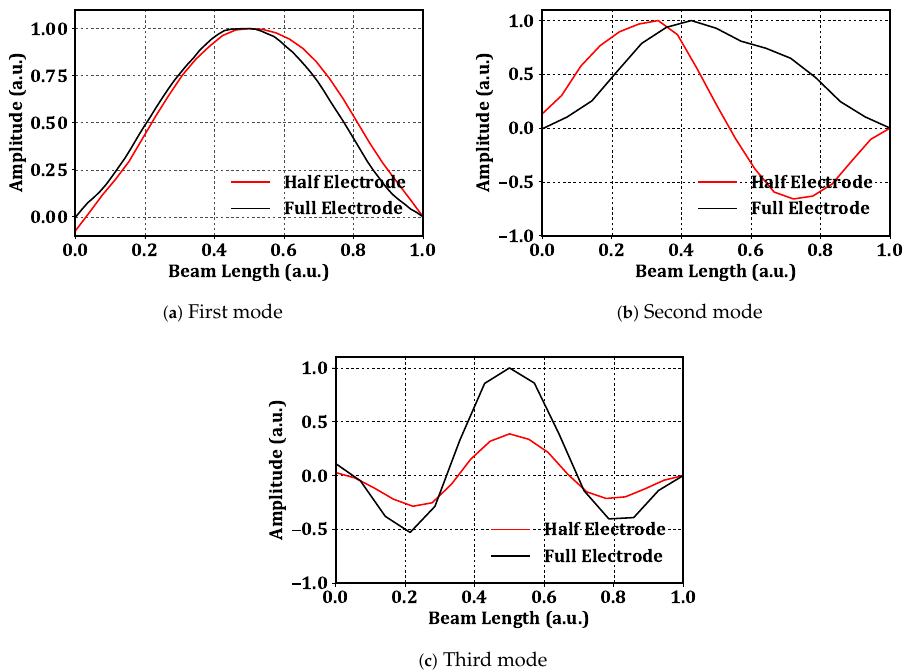
Figure 4. The first three mode shapes of the beam under half-electrode excitation (red) and full- electrode excitation (black) with the voltage waveform V AC = 2V and V DC = 2V. We swept the excitation frequency in the vicinity of each mode’s natural frequency, over a duration of 20 ms using the voltage waveform V AC = 2 V and V DC = 2 V.